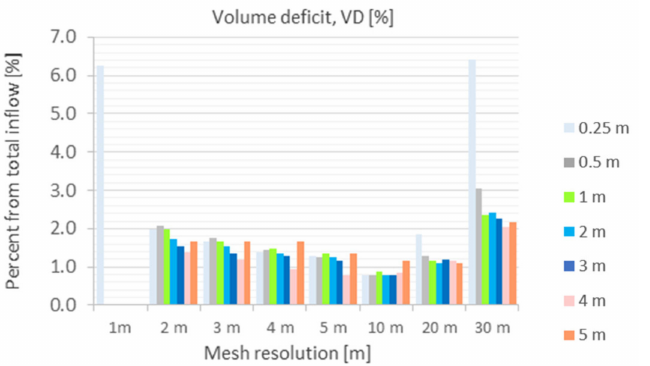
Figure 18. Overview of results of VD for the different mesh and DEM resolutions (DEM: colored legend).